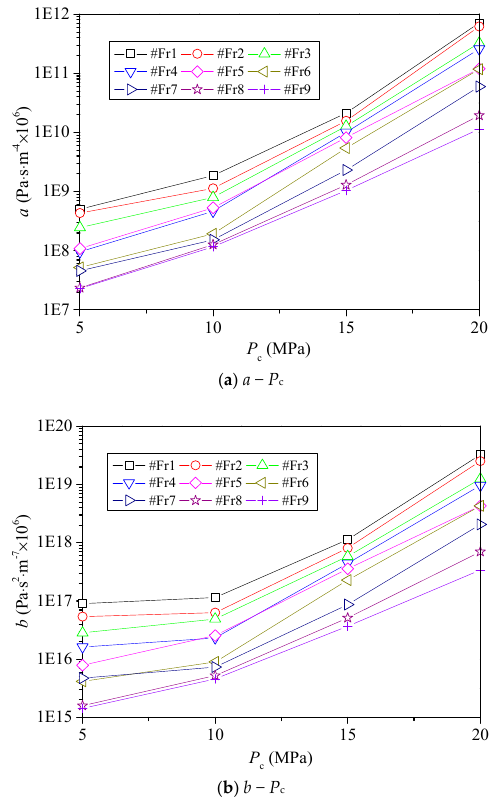
Figure 6. Variations of ( a ) linear coefficient a , and ( b ) nonlinear coefficient b of rough-walled fractures with the confining